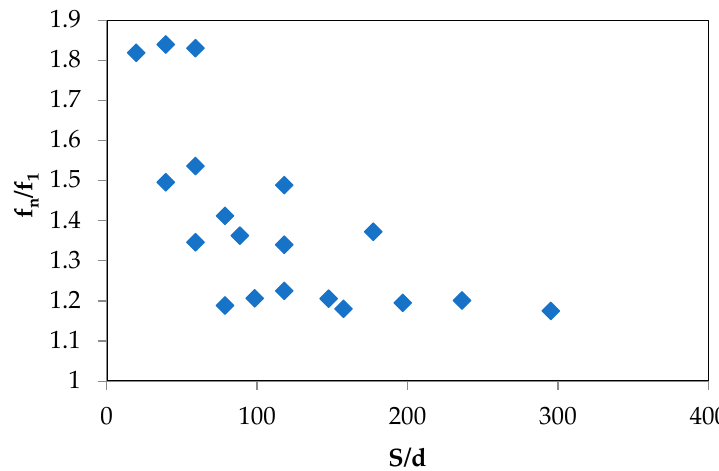
Figure 9. Variation of the coefficient of friction throughout the experiments.